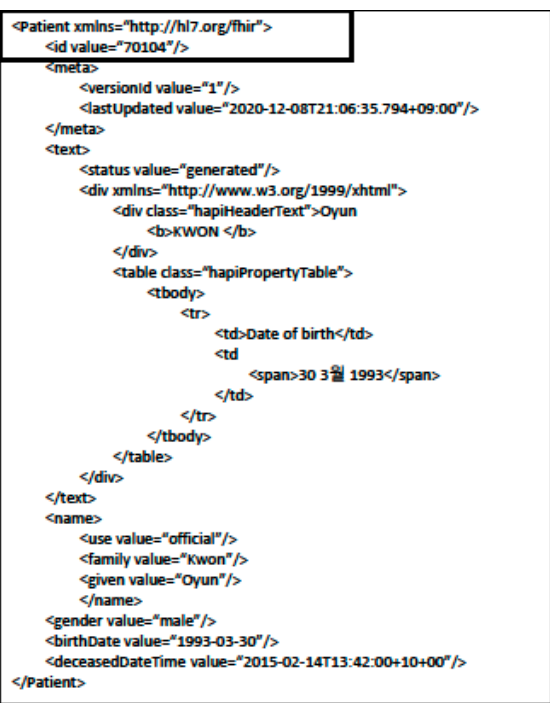
Figure 7. Example of Patient Resource XML Transmission Results.